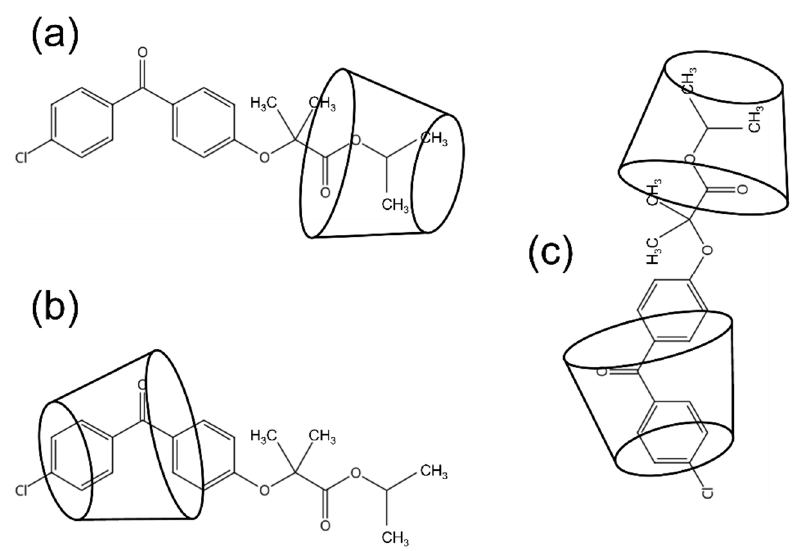
Figure 5. The proposed conformation of 1:1 FE/RM β CD complex ( a ) at the isopropyl group insertion of FE, ( b ) aromatic ring insertion of FE, and ( c ) 1:2 FE/RM β CD complex. Table 4. Physicochemical and chemical properties of the FE-loaded EuNP eye drop